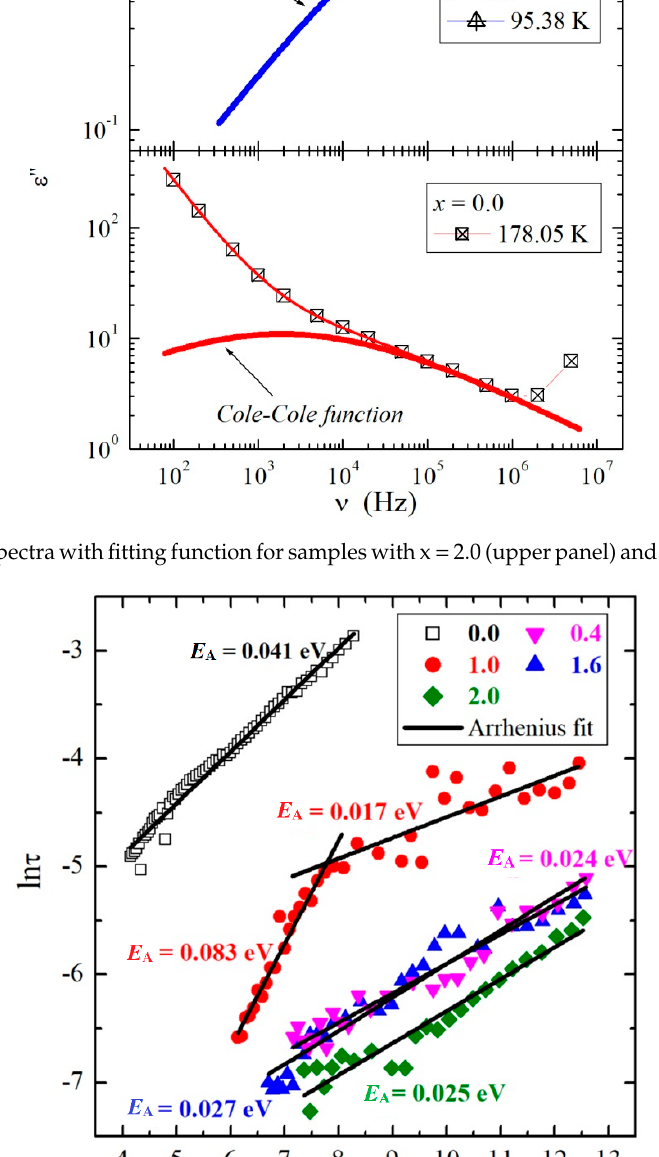
Figure 12. Arrhenius plot of the dielectric relaxation times, τ , for various samples. Straight (black) lines represent fits with constant activation energies, E A .